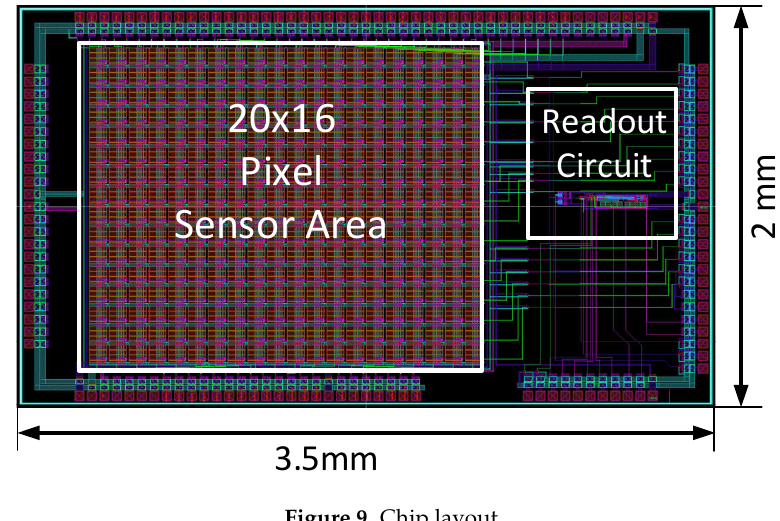
Figure 9. Chip layout. Table 3. Characteristics of the fingerprint chip and the sensor cell.